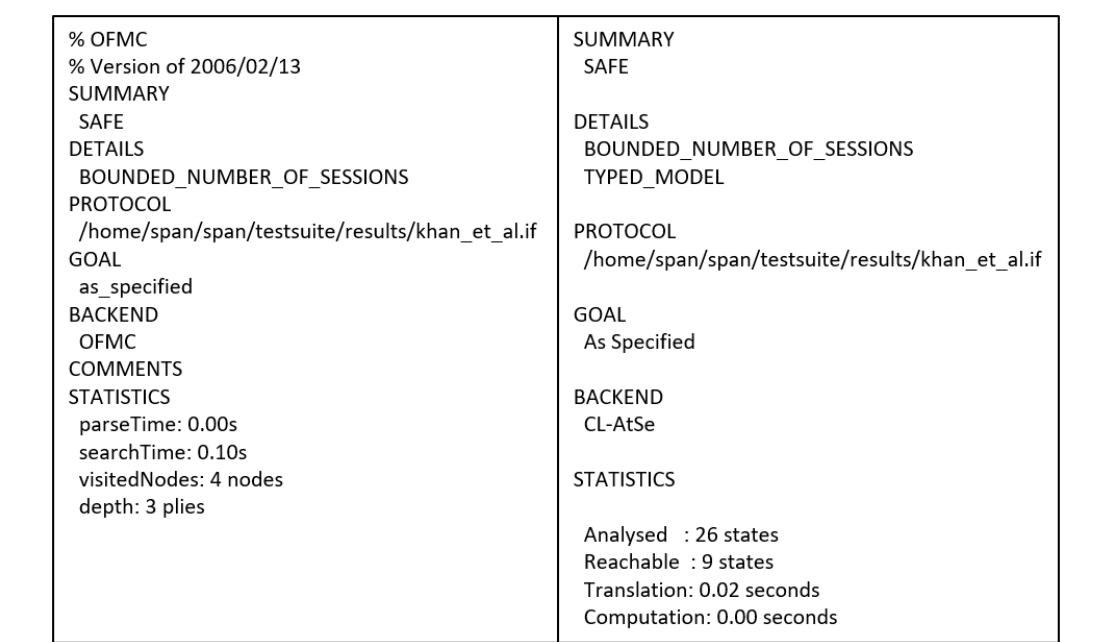
Figure 5. AVISPA result of Khan et al.’s protocol.